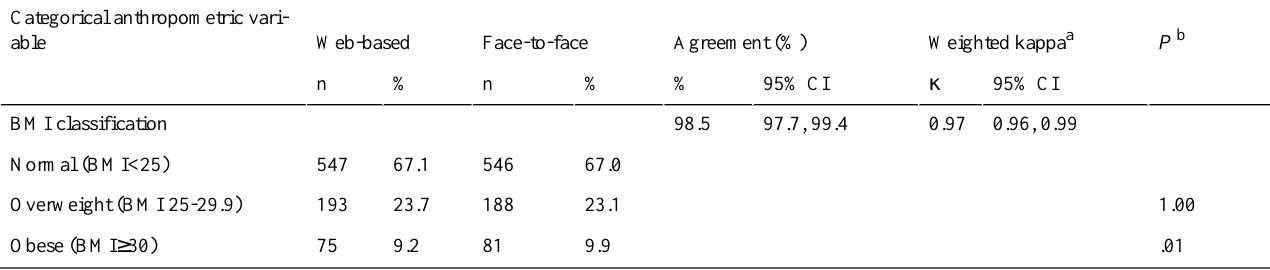
Table 5. Concordance indicators for categorical variables: percent of similar classification and weighted Kappa coefficient for overweight and obesity classification between Web-based and face-to-face reported data from the NutriNet-Santé Study, 2012, France (n=815). (%)Face-to-faceWeb-basedCategorical anthropometric vari-